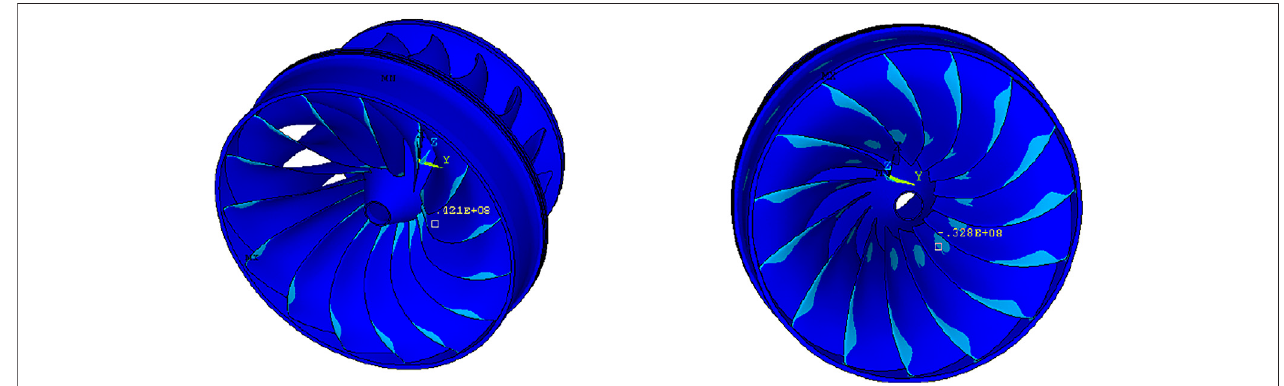
FIGURE 19 | The stress cloud diagram for the runner and blade (two-stage acceleration).